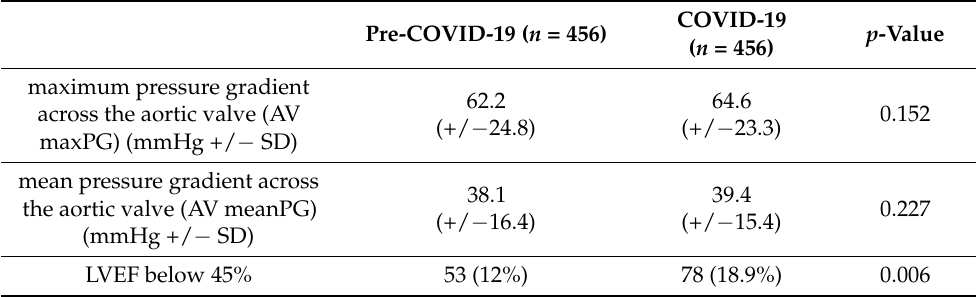
Table 6. Preprocedural echocardiographic